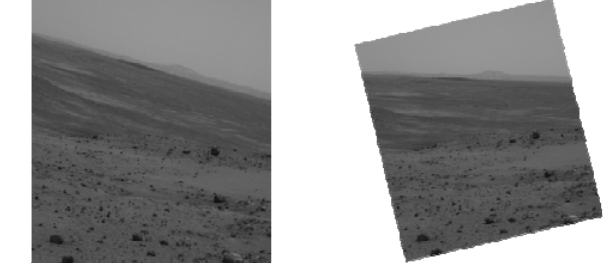
Figure 3. Horizon